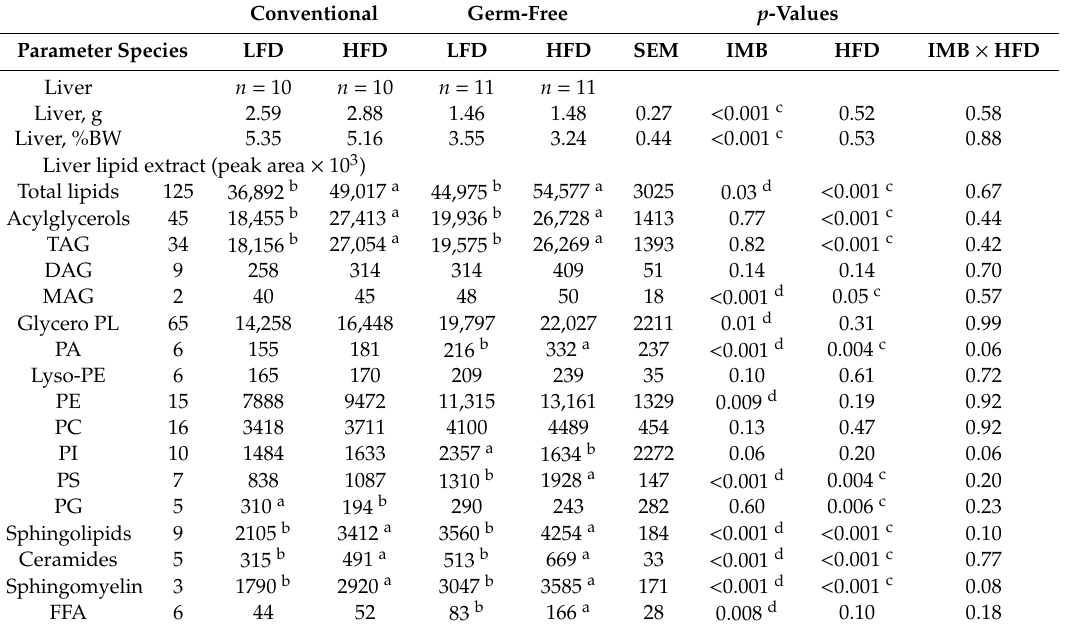
Table 7. E ff ect of the low- and high-fat diets on hepatic lipid abundance in conventional and germ-free male Tac:SW